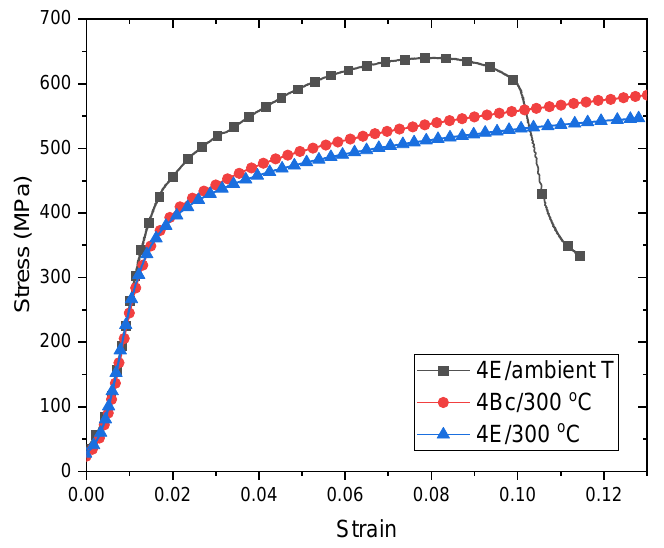
Figure 5. Compression stress-strain curves for Cu-Ta composites consolidated at 300 °C. For comparison, the stress strain curve for route 4E consolidation at ambient temperature is also shown.